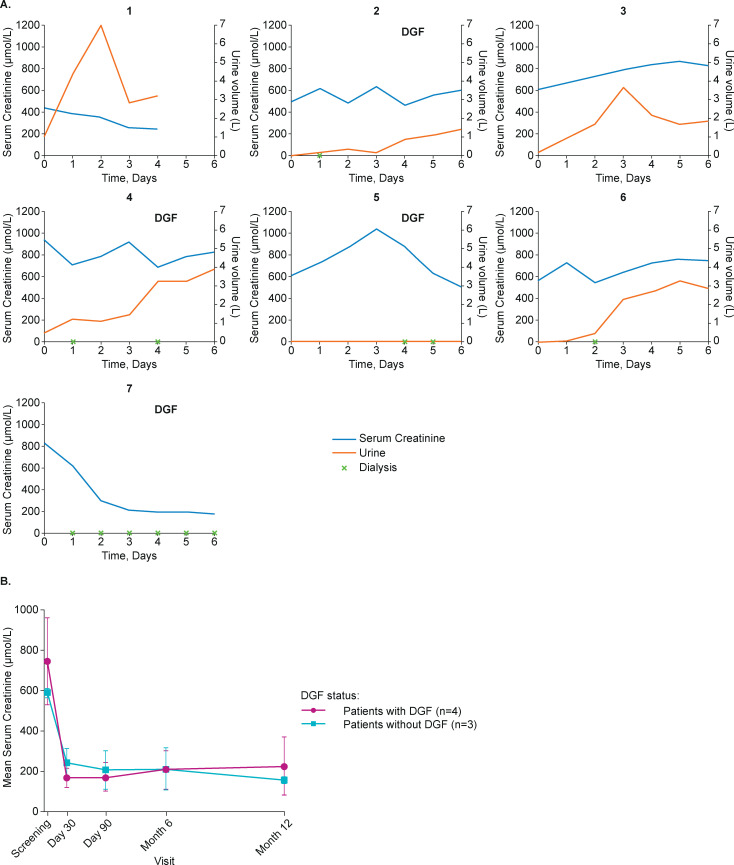
(A) Creatinine levels and urine output during the first 7 days following transplantation. (B) Mean serum creatinine by DGF occurrence over the study course. There was some variability between patients in timeframe and extent of data collection: Patient 1, no data collected for Days 5 and 6; Patient 5, urine output was negligible during this period; Patient 7, urine output not recorded due to patient undergoing continued dialysis during this period. Any event occurring at any time within a calendar day was charted at that study day, e.g., for Patient 4, dialysis at Day 1 as shown on the chart may have occurred at any time point during Day 1. DGF, delayed graft function.